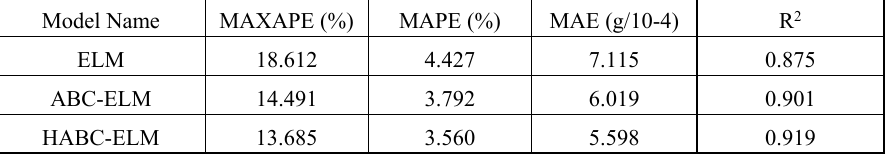
Table 3. Comparison of evaluation indexes of each model (low voltage phase